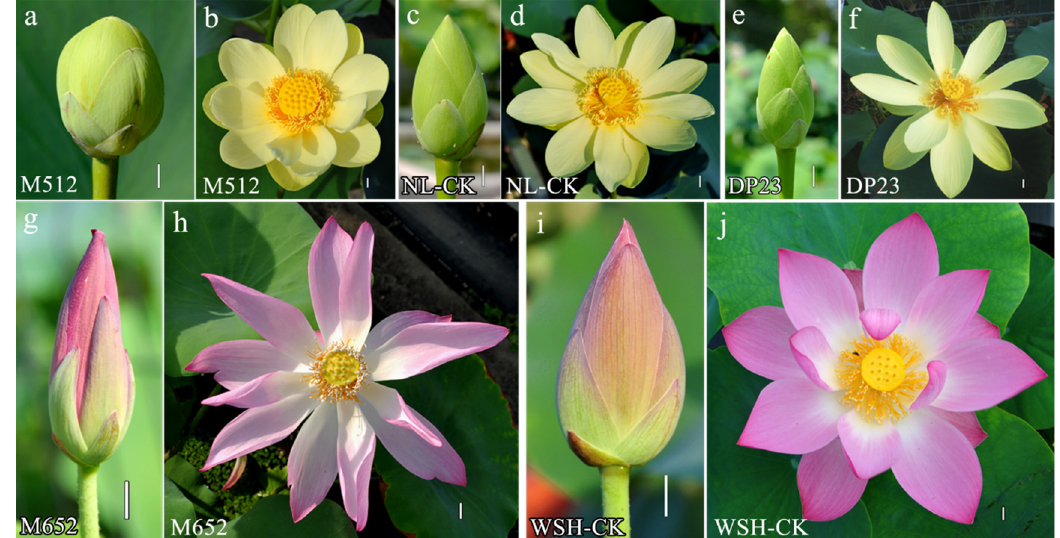
Figure 1. Buds and second-day flowers of NL group ( a – f ) and WSH group ( g – j ). The NL group accessions included M512 (( a , b ), wide-short tepals), DP23 (( e , f ), narrow-long tepals), and NL-CK (( c , d ), wild American lotus; the control). The WSH group accessions included M652 (( g , h ), derived from ‘Weishan Hong’ by gamma irradiation; narrow-long tepals) and WSH-CK (( i , j ), ‘Weishan Hong’ belonging to wild Asian lotus; the control). Scale bars = 1 cm.